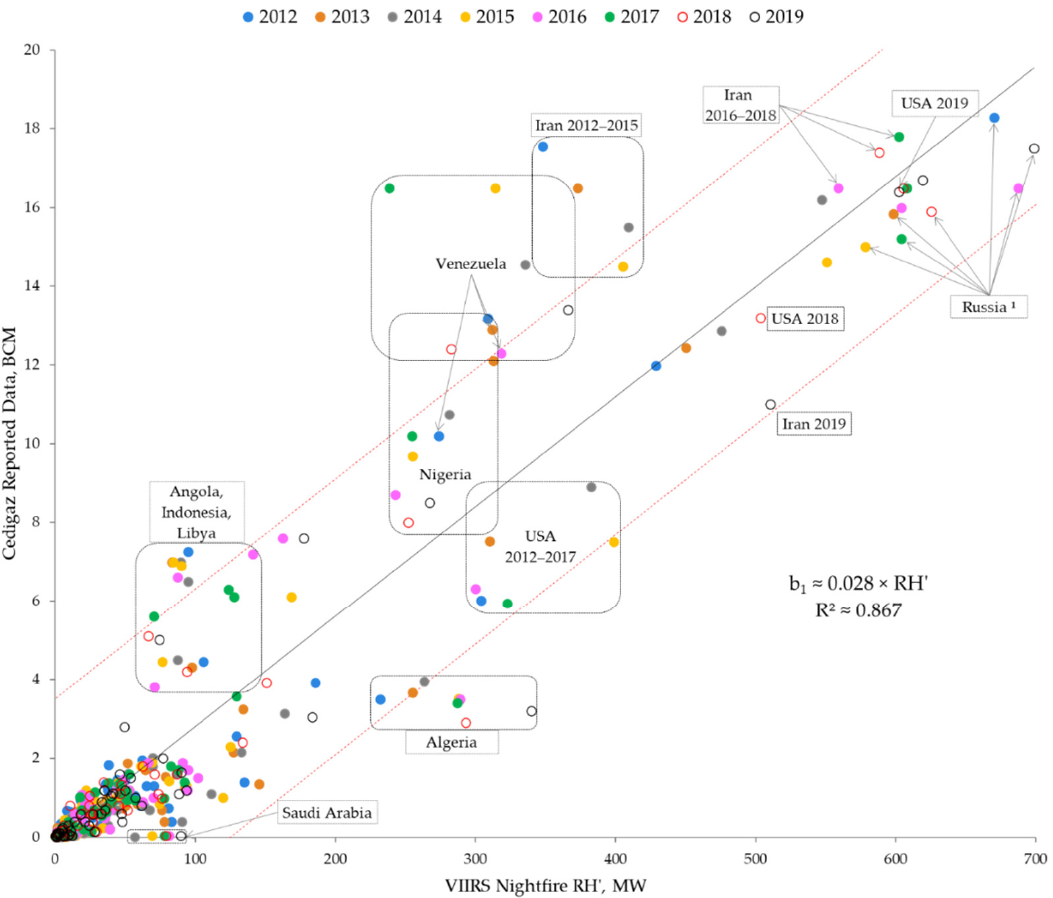
Figure 3. Plot VIIRS Nightfire estimated annual sum of radiant heat ( RH’ , in MW) vs. Cedigaz reported gas flaring volumes (in BCM) on national level. Calibration from 2012 to 2017 (solid fill points) is extrapolated to available data for 2018–2019 (unfilled points). The dashed red lines indicate the positions of the 95% confidence intervals. Nightfire RH’ estimates for Russia are presented for the oil upstream sector only.